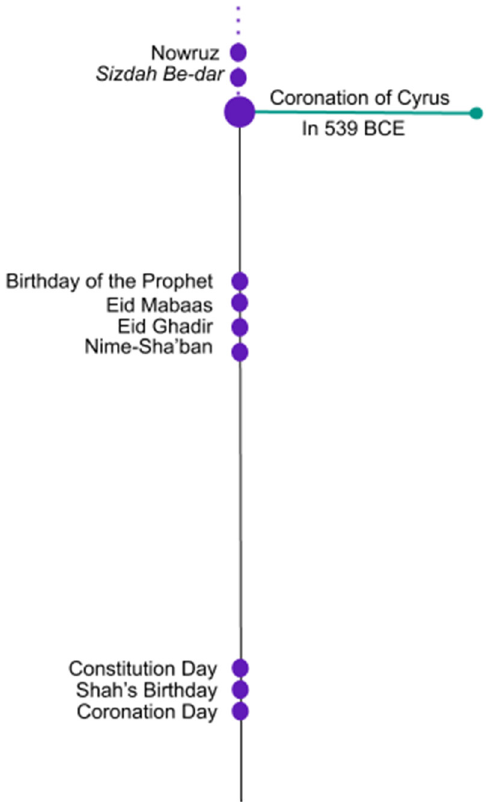
Figure 1. The Pahlavi’s National Commemogram.